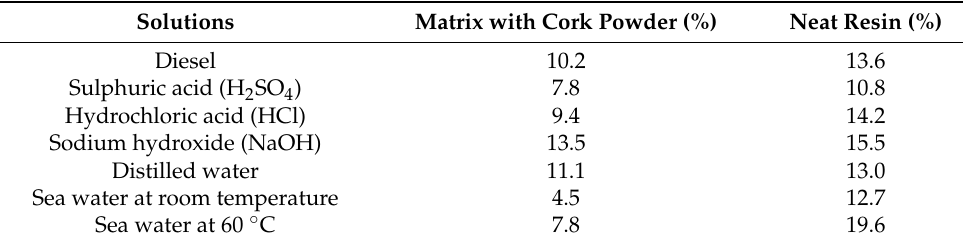
Table 4. Difference in the maximum impact load obtained for 30 days of immersion into different harsh solutions compared to non-immersed